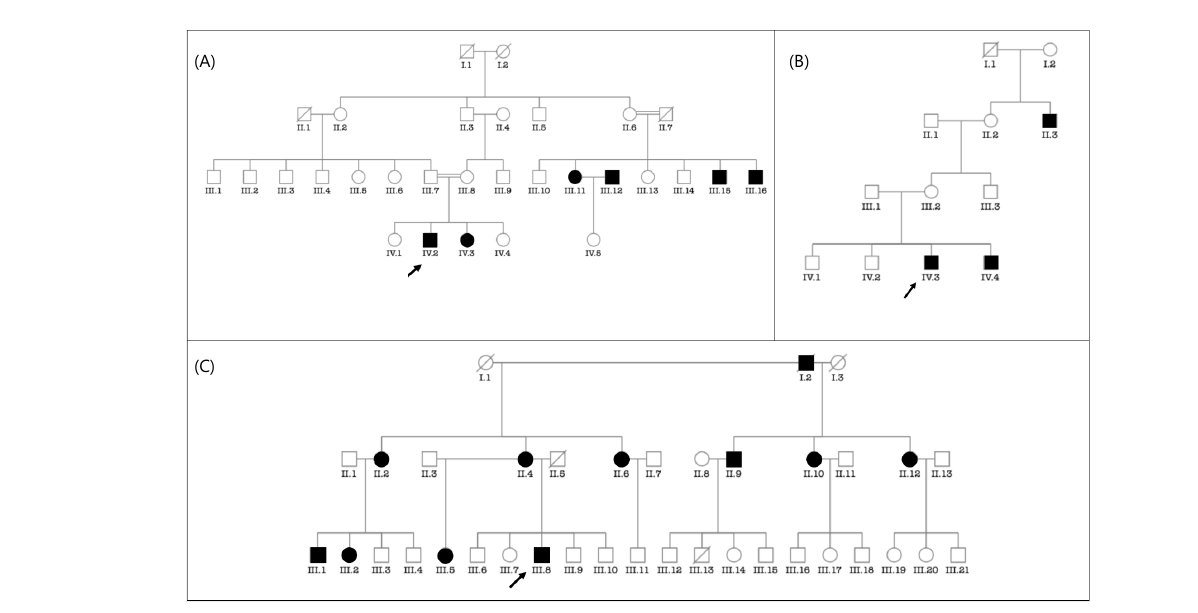
Figure 2. Typical modes of inheritance found in our cohort. ( A ) Pedigree of a consanguineous family with autosomal recessive non-syndromic hearing impairment. ( B ) Pedigree of a family with non- syndromic hearing impairment suggestive of X-linked recessive inheritance. ( C ) Pedigree of a family with autosomal dominant non-syndromic hearing impairment. Probands are indicated by arrows. Table 3. Etiologies of Childhood Hearing Impairment in Senegal.